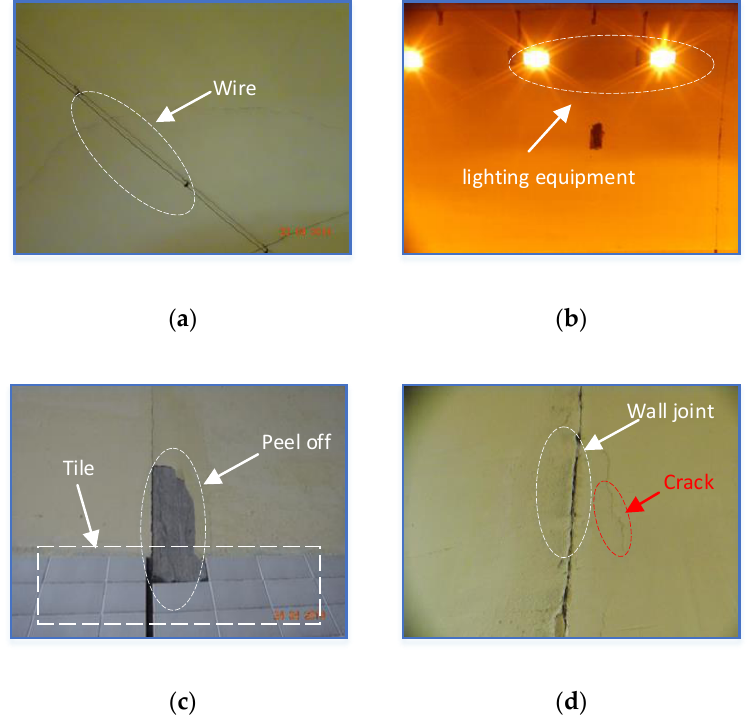
Figure 1. Some disturbing factors in the tunnel vault: ( a ) wire, ( b ) lighting equipment, ( c ) the calcimine peels off and tiles, ( d ) wall joint.